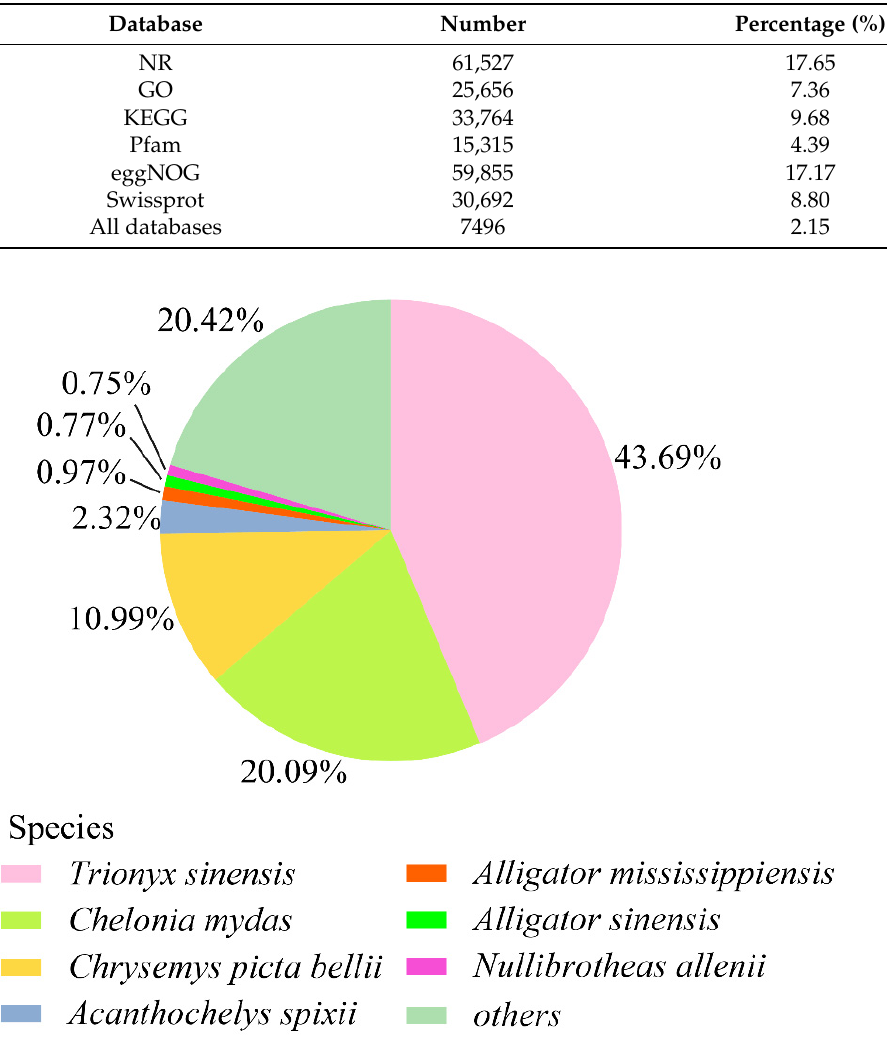
Figure 3. The distribution of species for the best matched unigenes in the NR database. The pie chart shows the top seven species that were highly homologous to the unigene sequences matched in the NR database.